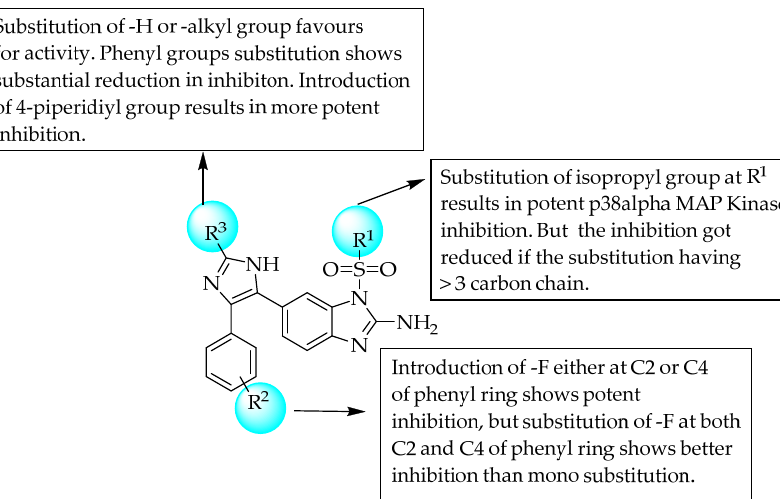
Figure 16. SARs of 2-amino-1-isopropylsulfonyl 6-substituted benzimidazole. In 2005, Dios et al. studied the importance of the N -sulfonyl group incorporated 2-aminobenzimidazole as a p38 α MAP kinase inhibitor. The compound with a piprid-4-yl at R 3 showed the highest efficacy and selectivity. A 2,4-difluoro substitution at R 2 led to better inhibition than mono-fluoro substitution; moreover, optimum steric bulky groups with three carbons at R 1 favoured p38 α MAP kinase inhibition [27]. However, bulkier groups at R 1 led to a reduction in the inhibition of p38 α MAP kinase activity. The SAR of the compounds is shown in Figure 17.